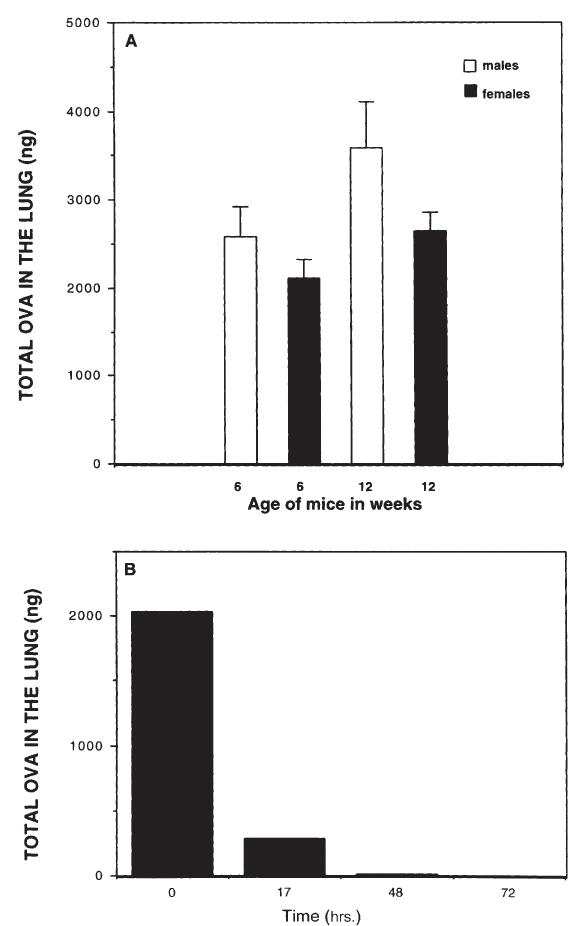
FIGURE 6 Measurements of OVA in the lung of BALB/c mice after exposure to a 1% aerosolized OVA. (A) Clearance of OVA from the lung of BALB/c mice after receiving 2000ng of OVA. (B) Mice were exposed to OVA aerosol and lungs were removed immediately, minced, and then suspended in 10ml. of RPMI. Suspension was centrifuged and supernatant assayed by ELISA for OVA. Ten mice of each gender were used in part A and an average of two mice/time point were sacrificed in part B, except for the 74h time point in which five mice/group were